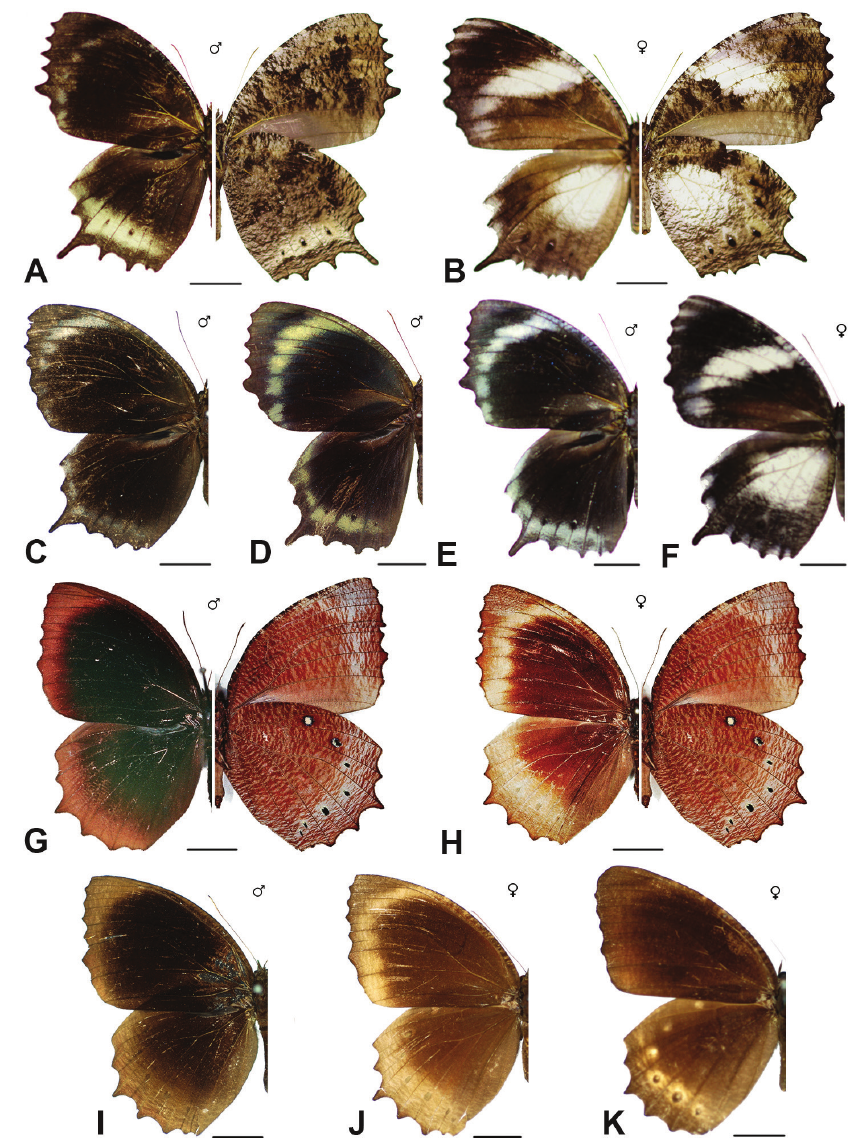
Figure 9. A harterti harterti ♂ D+V OPC Malaysia: Perak, Batang Padang, Tapah B harterti harterti ♀ D+V OPC Malaysia: Perak, Batang Padang, Tapah C harterti brookei ♂ D NHM collection locality unknown D harterti lautensis ♂ D OPC Indonesia: South Kalimantan, Laut Island; Holotype E harterti arbaimuni ♂ D OPC Indonesia: central Sumatra, Jambi; Holotype F harterti arbaimuni ♀ D OPC Indonesia: central Sumatra, Jambi G parce justini ♂ D+V SMFD Philippines: Palawan Province, Ca- lamian Islands, Busuanga Island, Coron; Holotype H parce justini ♀ D+V SMFD Philippines: Palawan Province, Calamian Islands, Busuanga Island, Coron; Paratype I parce parce ♂ D NHM Philippines: Palawan J parce parce ♀ D NHM Philippines: Palawan K panthera enganica ♀ D NHM Indonesia: Bengkulu, Enggano